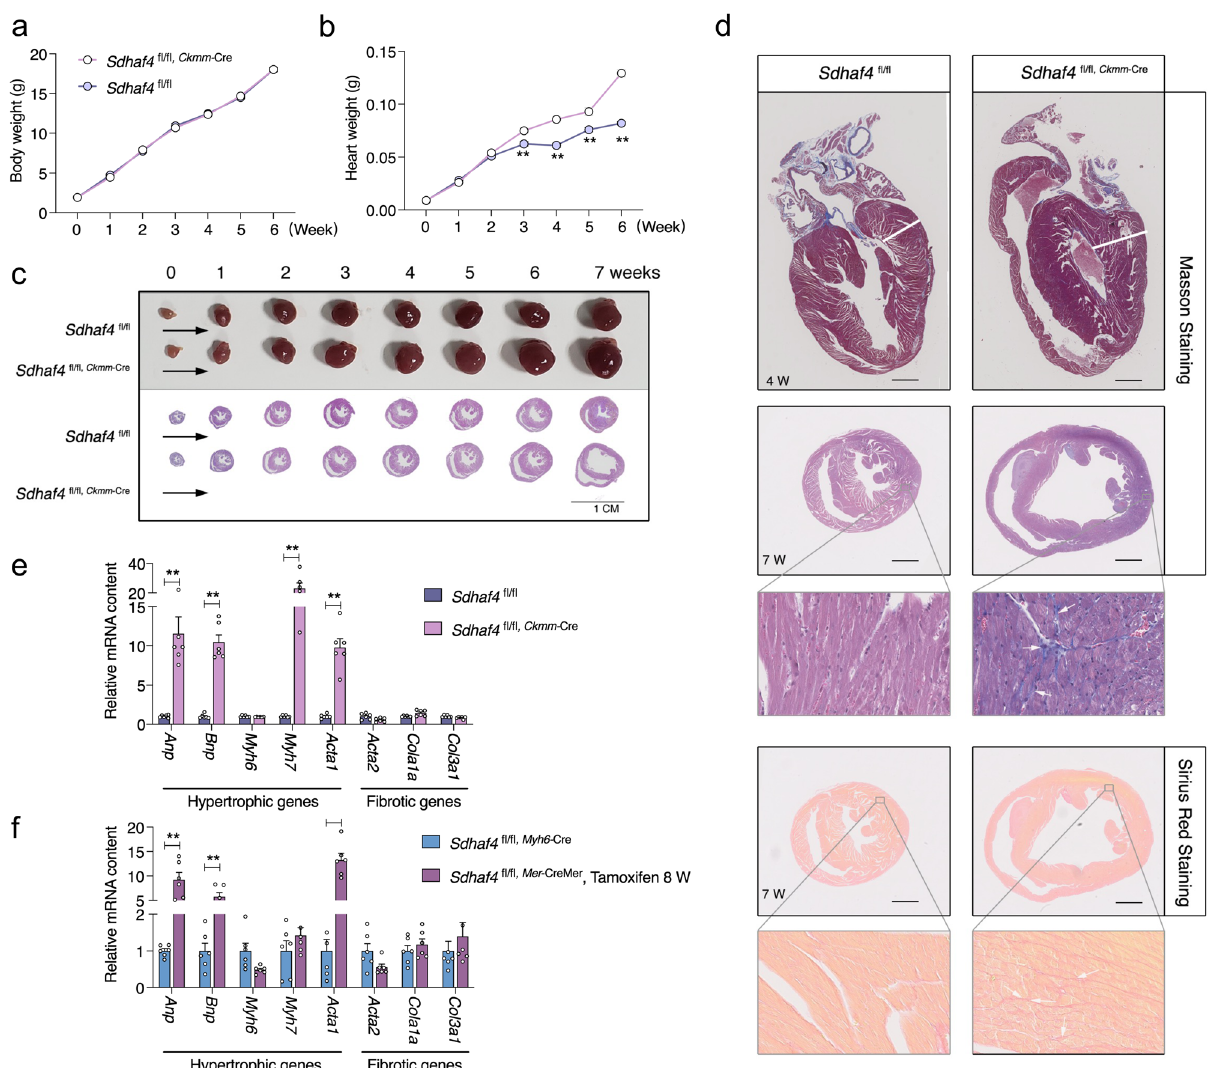
Fig. 3 Cardiac loss of SDHAF4 provokes dilated cardiomyopathy. a Postnatal bodyweight curves of WT ( Sdhaf4 fl / fl , n = 6) and Sdhaf4 mutant mice ( Sdhaf4 fl / fl , Ckmm -Cre , n = 6). b Postnatal heart weight curves of WT ( n = 6) and Sdhaf4 mutant mice ( n = 6), P = 0.002, 0.0001, 0.0018, 0.0001. c Macroscopic pictures and H/E histology of hearts of WT and mutant mice, scale bar, 1 cm. d Representative cardiac Masson trichrome staining of WT and mutant mice at age of 4 and 7 weeks, and Sirius red staining of WT and mutant mice at age of 7 weeks, scale bar, 3 mm. e Relative expressions of hypertrophic and fi brotic-associated genes in left ventricle of WT and muscle Sdhaf4 mutant mice, n = 6, P < 0.0001. f Relative expressions of hypertrophic and fi brotic-associated genes in left ventricle of WT and cardiac Sdhaf4 mutant mice, n = 6, P < 0.0001. Values are mean ± SEM, * P < 0.05, ** P < 0.01. Statistical signi fi cance was determined by two-tailed Student ’ s t -test ( b , e , f ). Source data are provided in Source Data fi